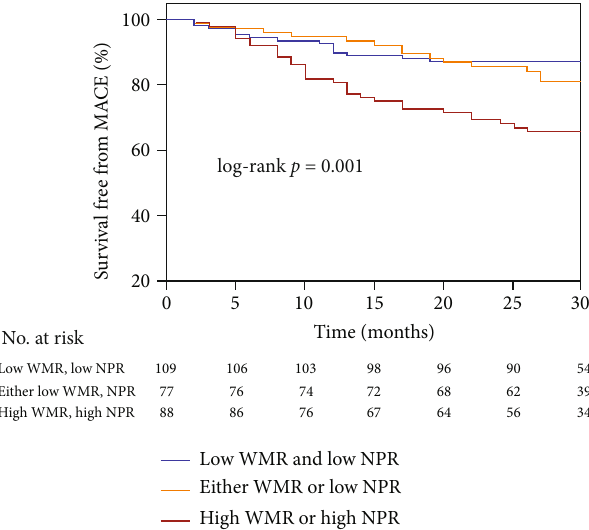
Figure 5: Kaplan-Meier survival curves for MACE in MINOCA patients with combined WMR and NPR median. WMR: white blood cell count to mean platelet volume ratio; NPR: neutrophil- to-platelet ratio; MACE: major adverse cardiovascular events.